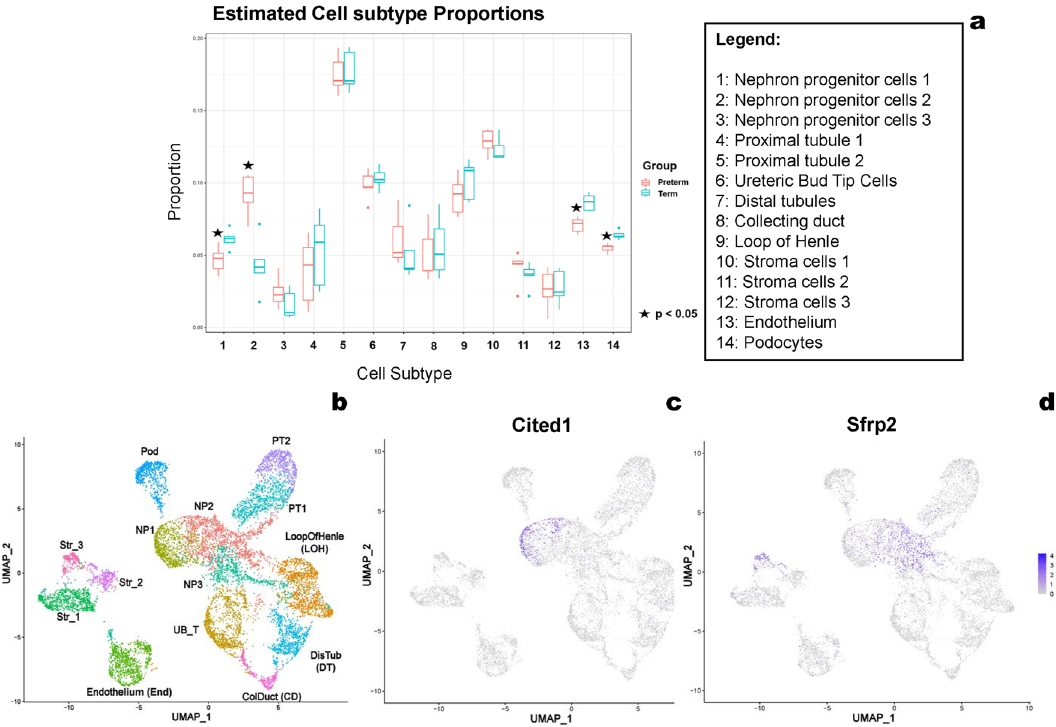
Figure 3. Preterm birth alters the cell subtype proportion of the kidney. A cell subtype proportion analysis on RNA-seq data showed kidneys from the preterm group had a decreased proportion of nephron progenitor 1 cells (NP1) and an increased proportion of NP2 cells (NP). The cell proportion of endothelial cells and podocytes was also lower in the preterm group. Identified cell subtype clusters in the scRNA-seq data ( b ). The nephron progenitor subpopulation marker genes Cited1 and Sfrp1 were used to classified the NP subpopulations with Cited1 marking the nephron progenitor 1 cluster (NP1) ( c ) and Sfrp2 marking the more differentiated nephron progenitor 2 cluster (NP2) ( d ). *Abbreviations in part b: NP1–3, nephron progenitor cells 1–3; UB_T, ureteric bud tip cells; Str_1–3, stromal cells 1–3; Pod, podocytes; PT1–2, proximal tubule 1–2; LOH, Loop of Henle; DT, distal tubule; CD, collecting duct; End, endothelium.